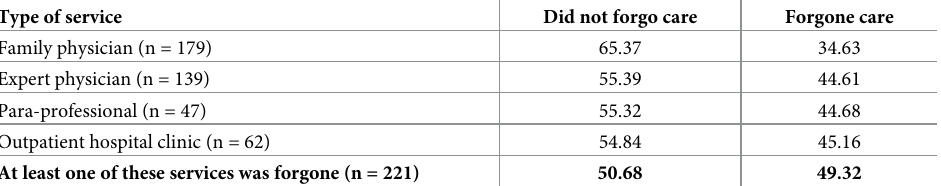
Table 3. Percentage of forgone care for the most needed medical services. Type of